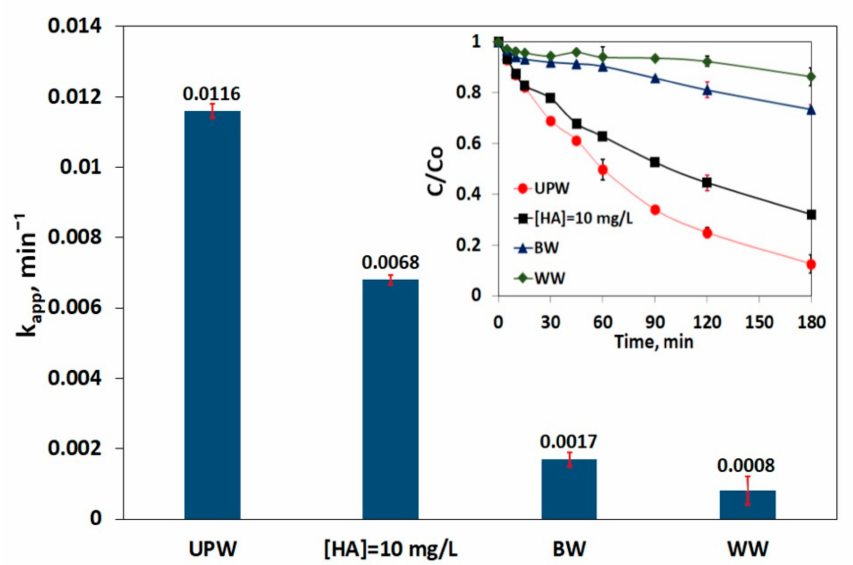
Figure 7. Effect of matrix on the kinetics of 500 µ g/L SMX photodegradation and (Inset) on 500 µ g/L SMX degradation, [0.50 CoP/BVO] = 1000 mg/L, pH = 5.5, UPW.